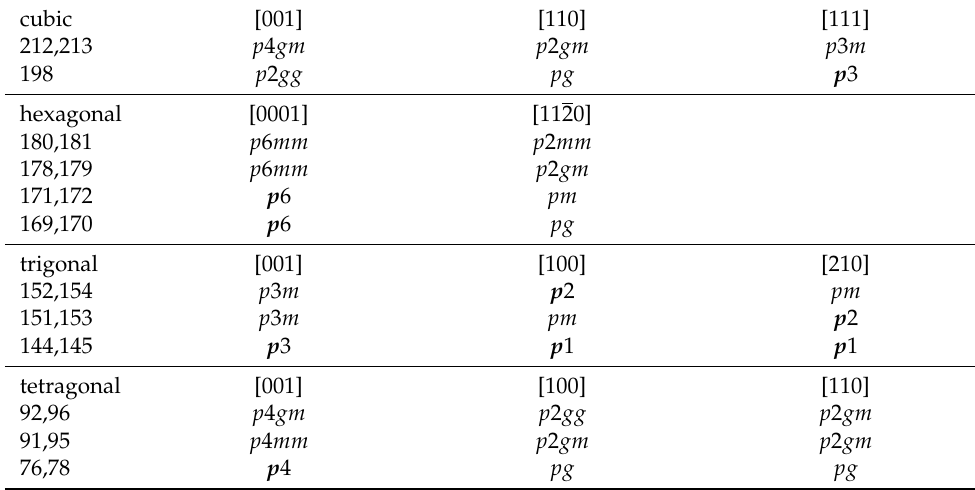
Table 9. Symmetry of special projections of the chiral space groups. Chiral projections are marked by printing their plane groups ( p i , i = 1,3,4,6) in bold. The cubic, achiral Sohncke group 198 is given for comparison.